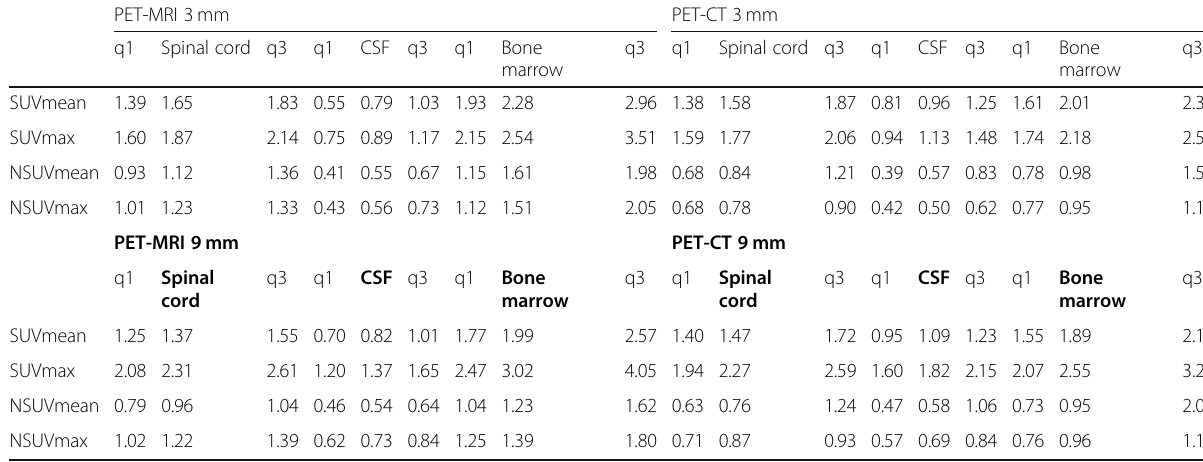
Table 4 Median and 1st and 3rd quartile values of the average spinal cord, CSF at L3 level, and average vertebral bone marrow calculated for each method and